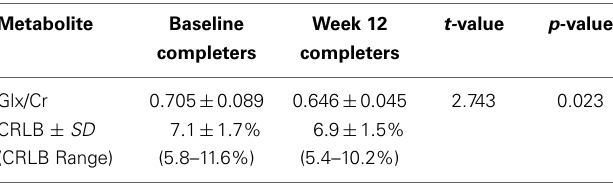
Table 2 | Glutamate Measurement in Dorsal Anterior